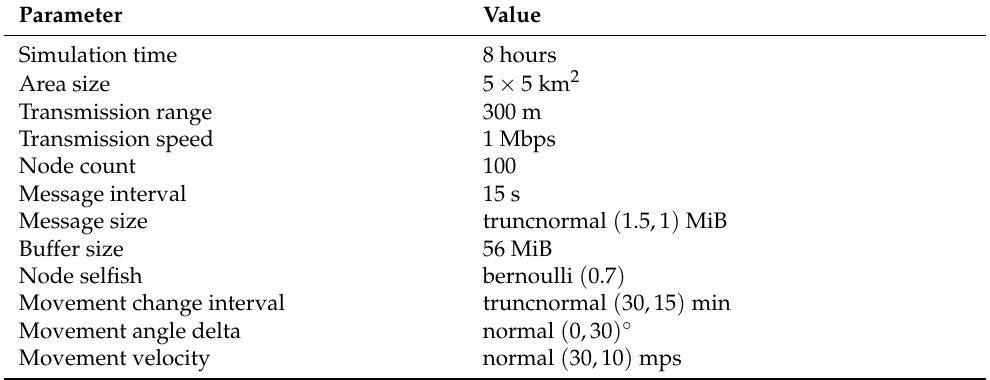
Table 1. Simulation